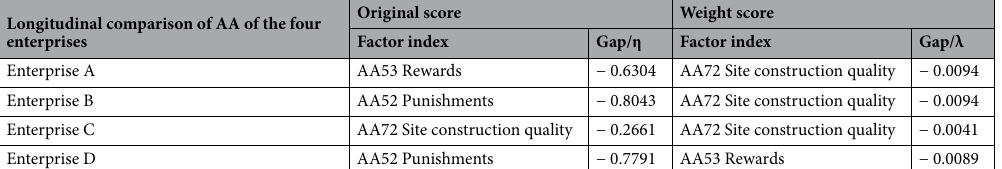
Longitudinal comparison of the indexes of subsystem A of the four enterprises